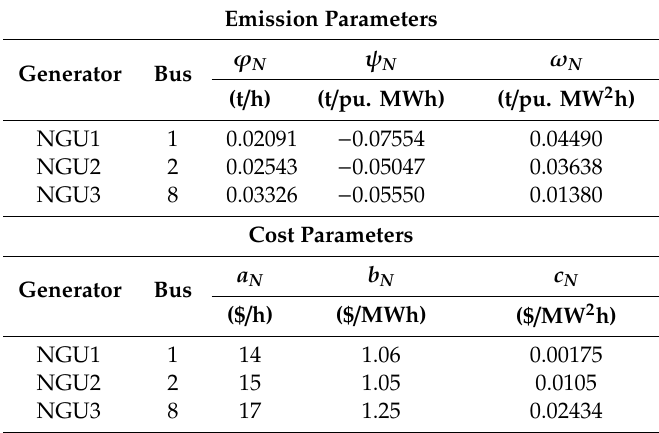
Table 5. Emission and cost parameters of the NGUs